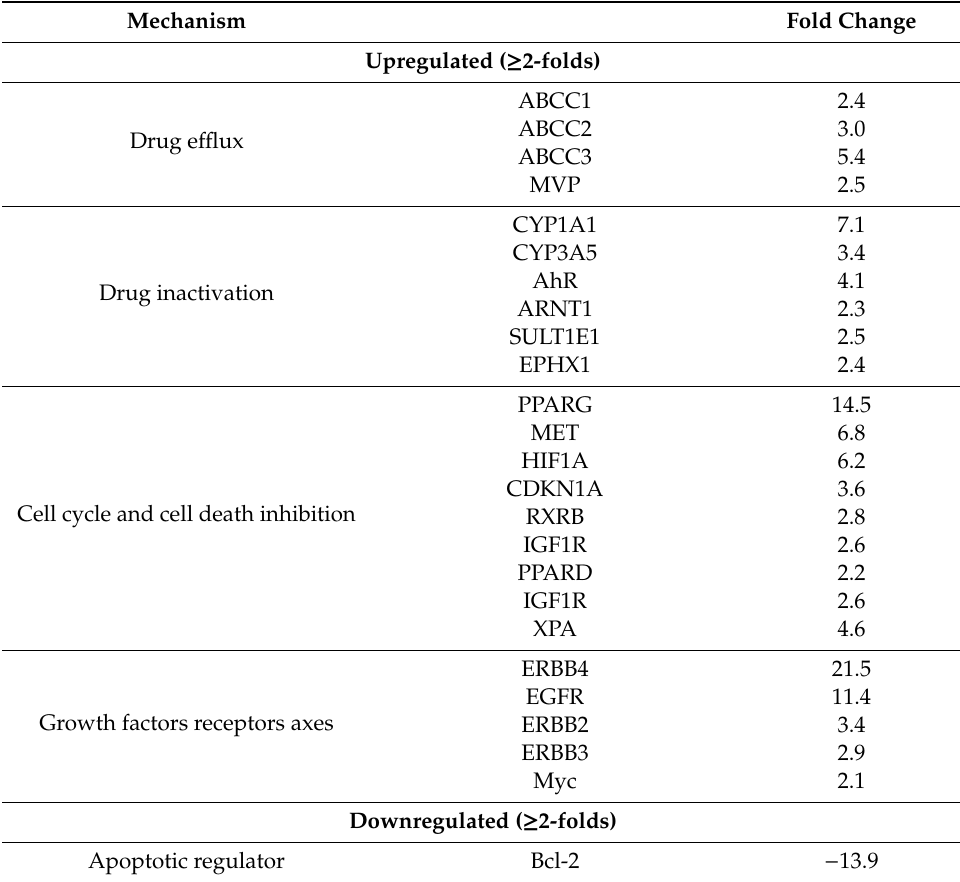
Table 1. The genes expression profiling of multidrug resistant-related genes in MCF7_DoxR compared to the MCF7_DoxS parental cells analyzed by RT2 profiler PCR array. A standard 2-fold change was used as arbitrary cut-o ff